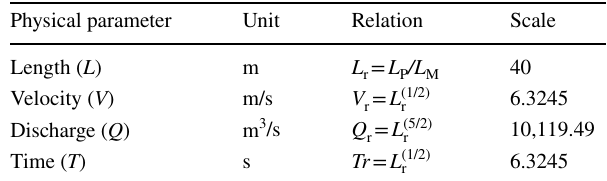
Table 1 Model and prototype scales according to Froude number